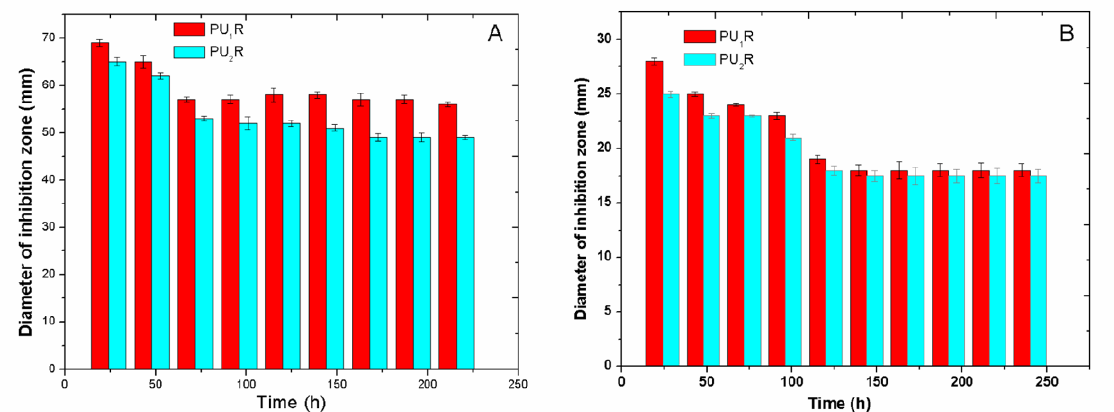
Figure 8. Diameter of inhibition area for PU